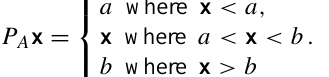
be obtained by a variety of means, for example obtained by the maximum electron density value in the Parameterized Ionospheric Model (PIM) (Daniell et al., 1995) simulation.